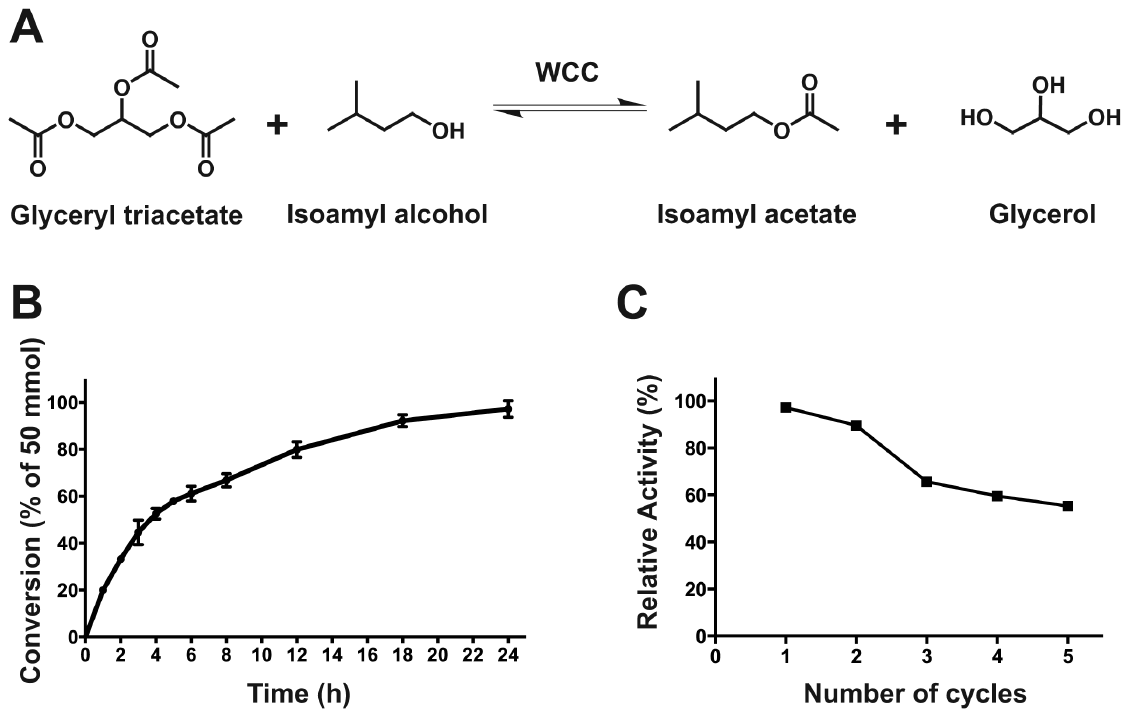
Figure 4. Time-course conversion of glyceryl triacetate into isoamyl acetate using the LipIAF5-2 WCB. A) Reaction scheme for the transesterification of glyceryl triacetate into isoamyl acetate in presence of isoamyl alcohol. B) Time-course production of isoamyl acetate by LipIAF5- 2 WCB immobilized in a fluidized bed reactor. C) Effect of LipIAF5-2 WCB recycling on the conversion yield of isoamyl acetate production. One gram of LipIAF5-2 WCB was loaded in an empty HPLC preparative column with a dead volume of 10 cm 3 and placed in a heated chamber. The reaction mixture contained 50 mmoles of glyceryl triacetate as acyl donor and isoamyl alcohol at a molar ratio of 5:1 with 5% water (w/w). The mixture was pumped in recirculating mode through the column at a flow rate of 1 mL/min for 24 h for each cycle. Cells were washed in open mode with 350 mL of tert -butanol between each cycle. All experiments were performed in triplicate.